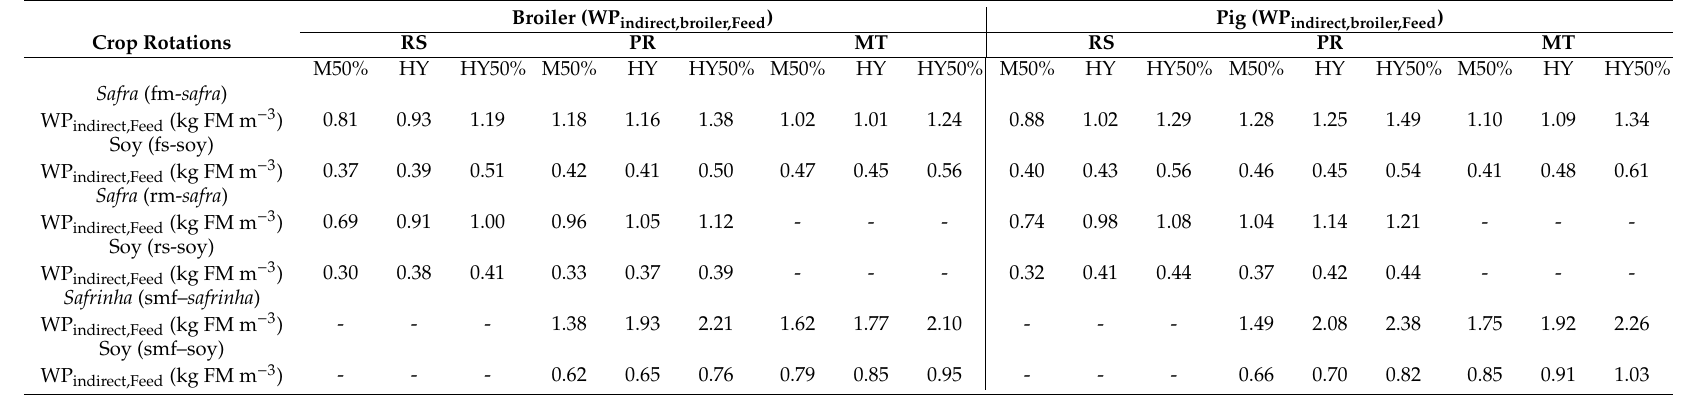
Table 4. Potential improvement of WP indirect,Feed of rainfed maize and soy produced in the Brazilian sites analyzed (2008 / 18) in the 2nd scenario (M50%): soil evaporation ratio less 50%; 3rd scenario (HY): higher yield; 4th scenario (HY50%): higher yield scenario with a lower soil evaporation ratio of 50%. (FM: fresh matte; PR: Cascavel (city) located in Paran á State; RS: Vacaria (city) located in Rio Grande do Sul State; MT: Primavera do Leste (city) located in Mato Grosso State.). Broiler (WP indirect,broiler,Feed )